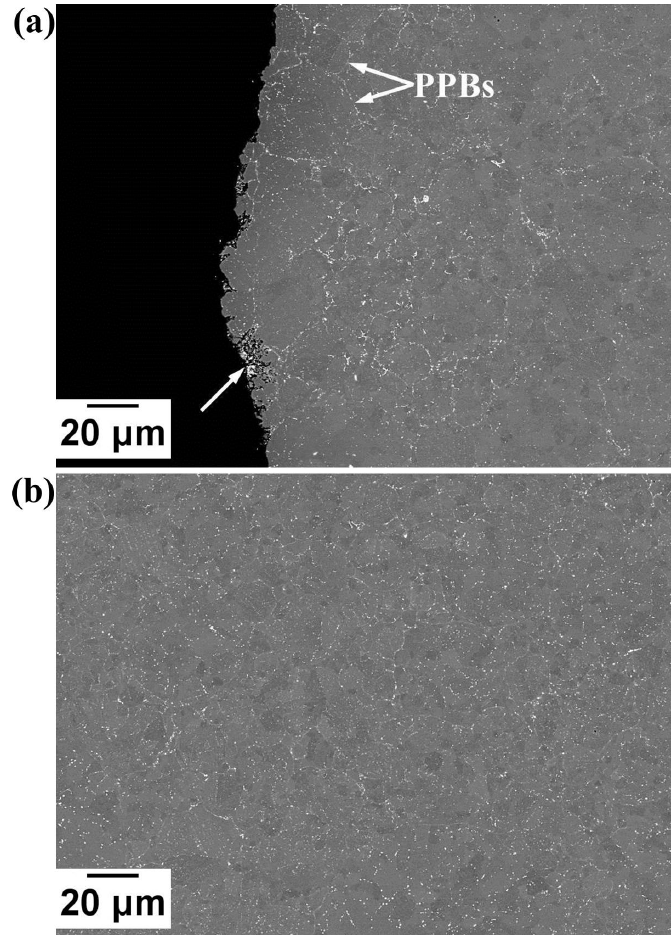
Figure 17. BSE micrographs showing ( a ) the thinnest part of the blade, where the nonconsolidated area is indicated by the white arrow; ( b ) further away from the edge of the blade.